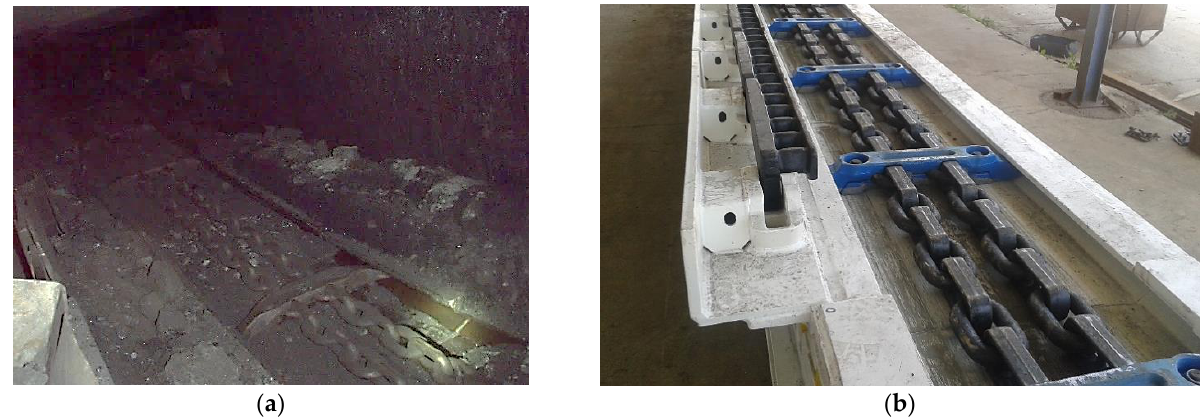
Figure 1. Armoured face conveyor; ( a )—during the run-of-mine transportation, ( b )—not loaded.